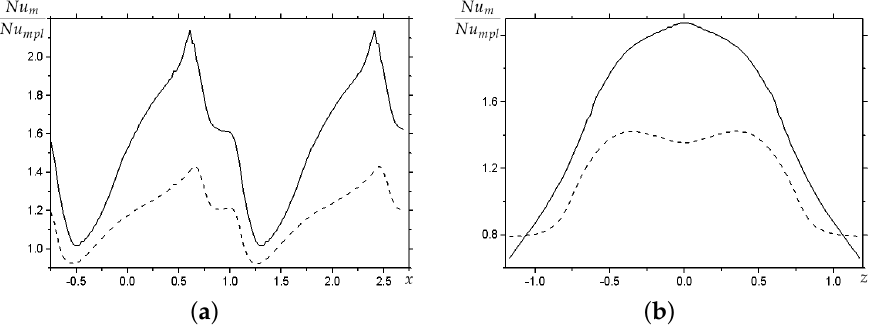
Figure 13. Comparison of band-averaged distributions with oval dimples of relative Nu ( x ) ( a ) and Nu ( z ) ( b ). The solid lines are ∆ = 0.2 and the dashed lines are 0.1.